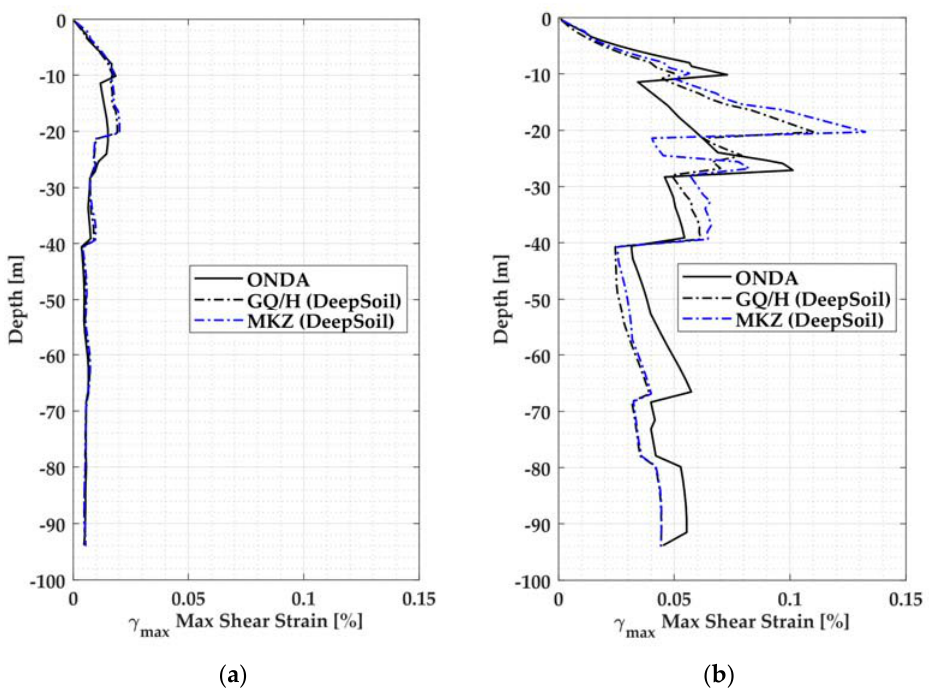
Figure 18. Comparison between the peak shear strain profiles using different SRA analyses: ( a ) RP = 130 years–input motion GSA; ( b ) RP = 500 years–input motion AQK.